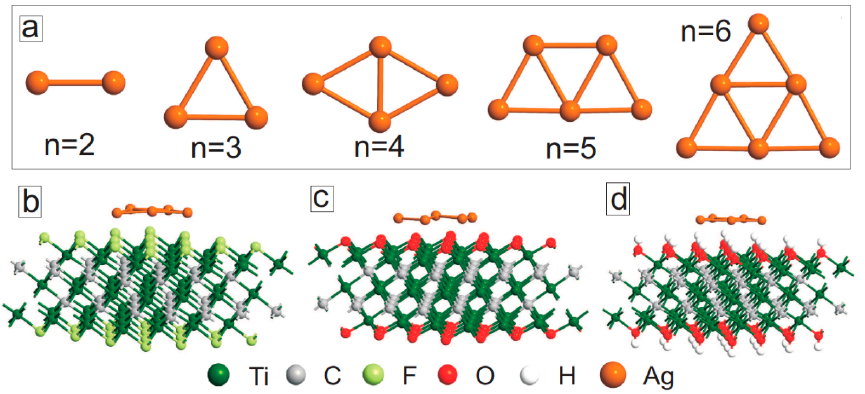
Membranes 2021 , 11 , x FOR PEER REVIEW